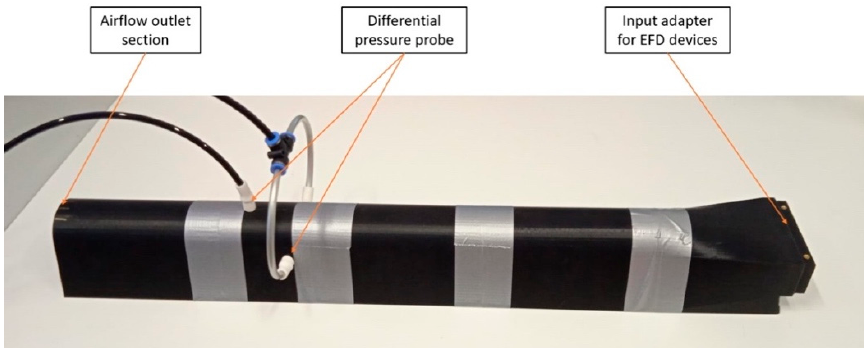
Figure 3. Modular wind tunnel for evaluating the corona devices.